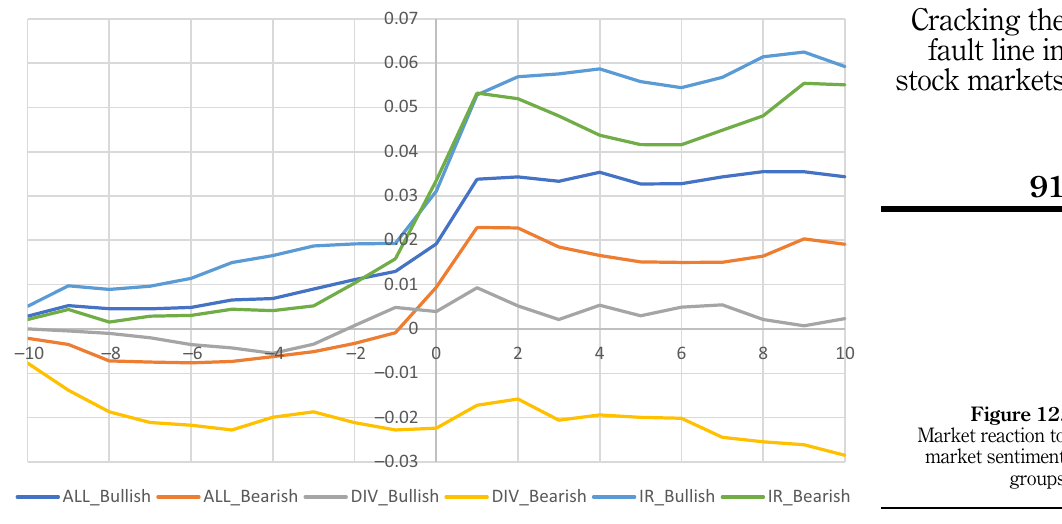
Figure 12. Market reaction